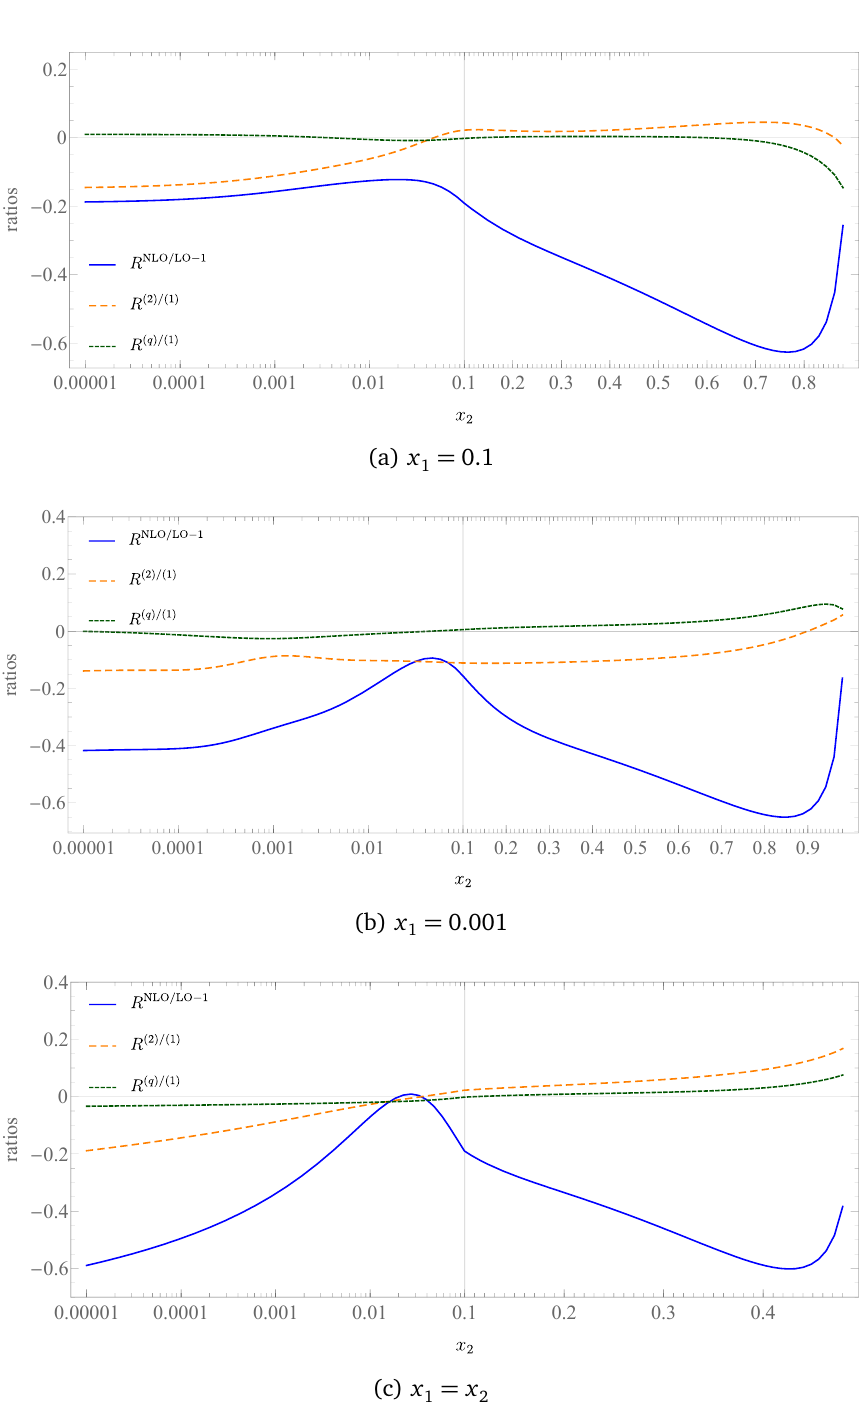
Figure 8: The ratios (174) corresponding to the curves shown in figure 7. Also shown is the ratio R ( q ) / ( 1 ) defined in (176), which quantifies the importance of quark and antiquark splitting contributions to F NLO